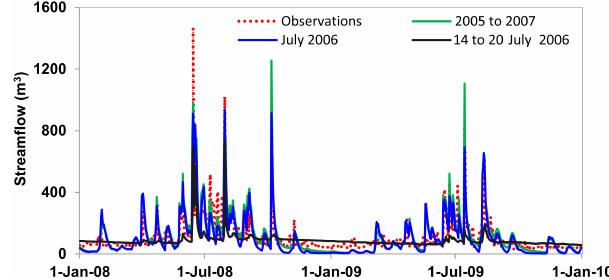
Figure 8. Simulated streamflow of validation period (2008 to 2009) for the Jinjiang Basin case corresponding to the best performed behavioral parameter set derived from calibration using 3-year data (2005 to 2007), one month (July 2006), one week (14 to 20 July 2006) and in situ